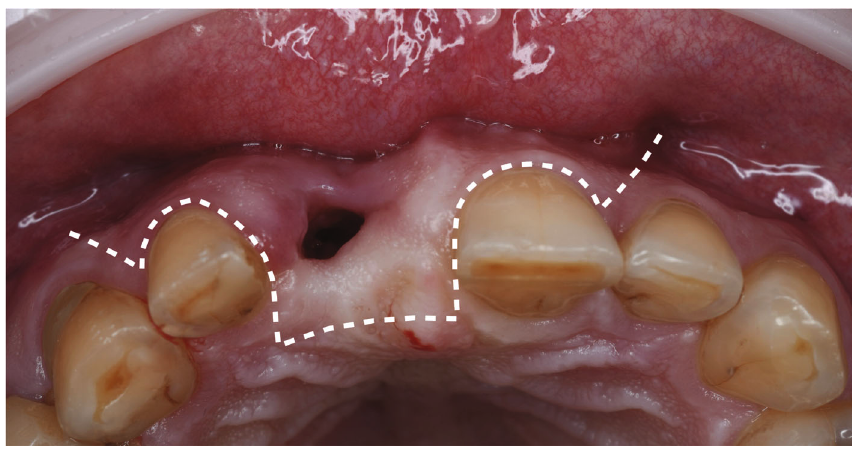
Figure 3: Flap design.